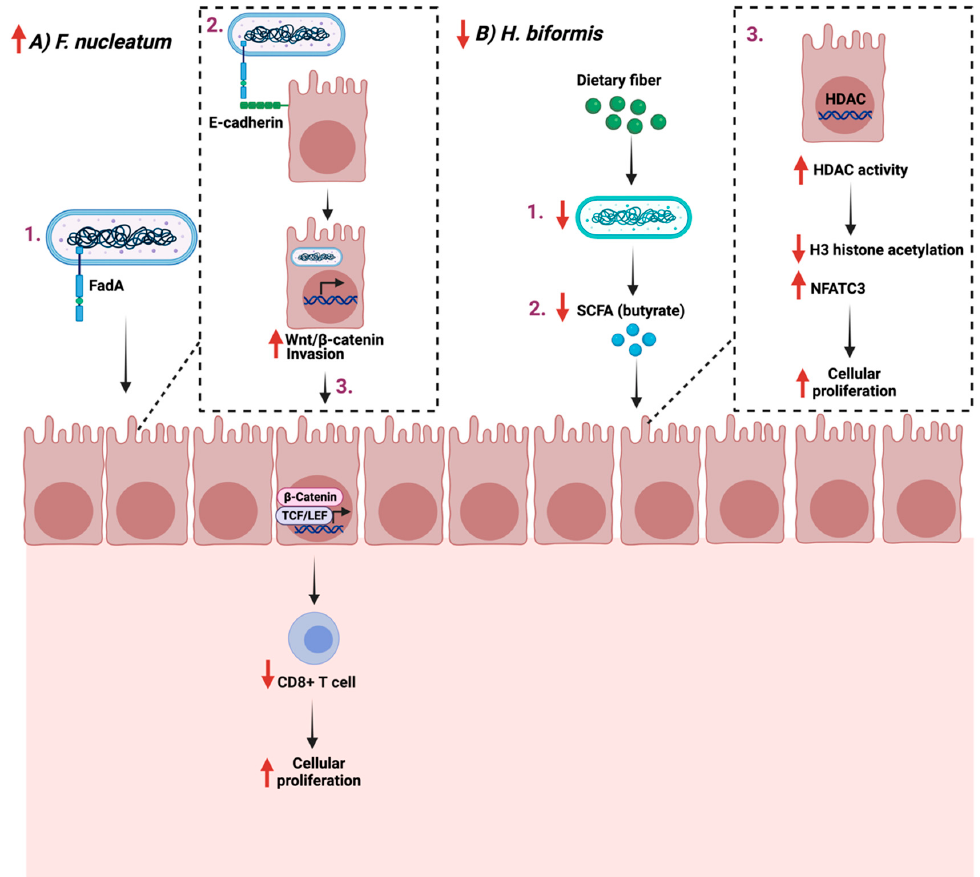
Figure 4. Schematic illustration of two pathways in which two bacteria Fusobacterium nucleatum and Holdemanella biformis facilitate cancer progression and cellular proliferation through FadA- E-cadherin interaction and short chain fatty acids (SCFA), respectively. ( A ) represent the proliferative example while ( B ) the anti-proliferative example. “Created with BioRender.com”.